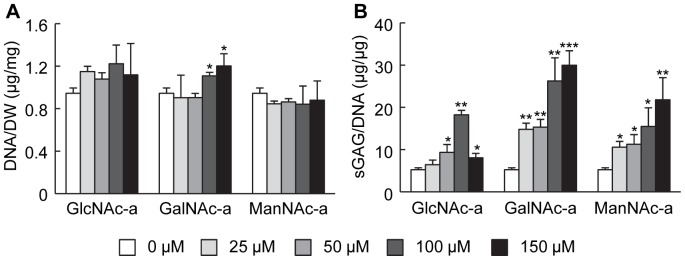
Biochemical analysis of DNA and sGAG for 3D hydrogels of bovine chondrocytes exposed to hexosamine analogs in combination with 10 ng/ml IL-1β.(A) Dry weight of DNA normalized to the construct had minimal variability across all conditions (n = 3). (B) sGAG accumulation, normalized to DNA content, increased with increasing concentrations of hexosamine analog for all conditions except 150 µM GlcNAc-a exposure (n = 3, * P<0.05, **P<0.01, *** P<0.001 versus no analog exposure).